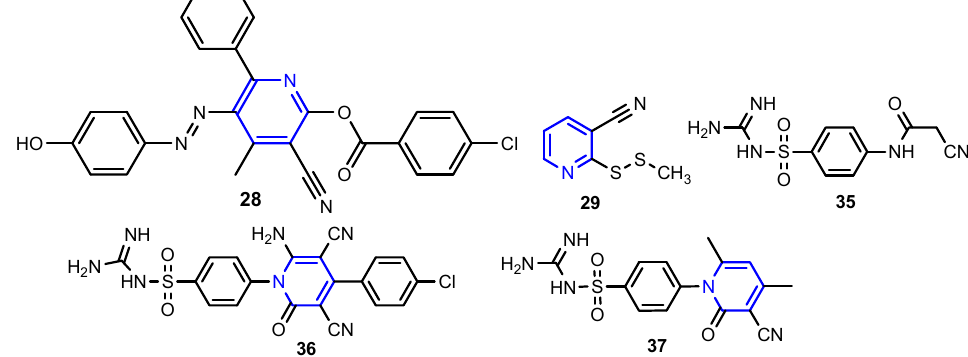
Figure 2. Structure of pyridine compounds 28 , 29 , 36 , 37, and intermediate 35 [19,20,22]. Table 1. In vitro antibacterial activity (minimal inhibitory/bactericidal concentrations, MIC and MBC), expressed in µM, for sulfonamides 36 and 37 [22].